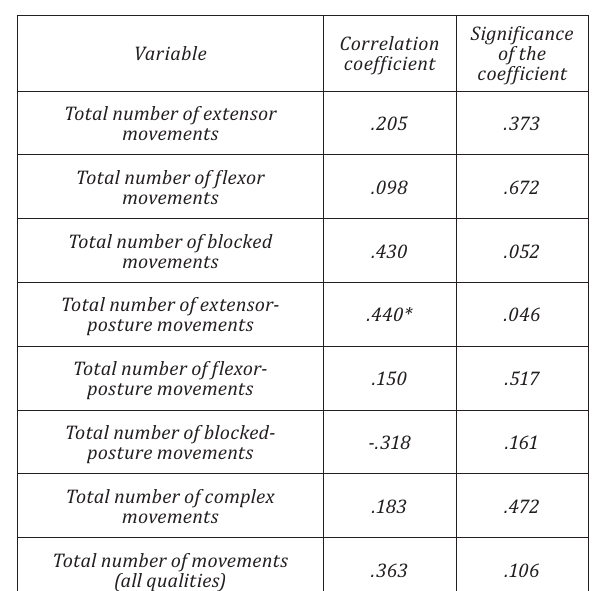
Table 7. The values of Spearman’s rho between the shading variable and movement quality variables in the group of